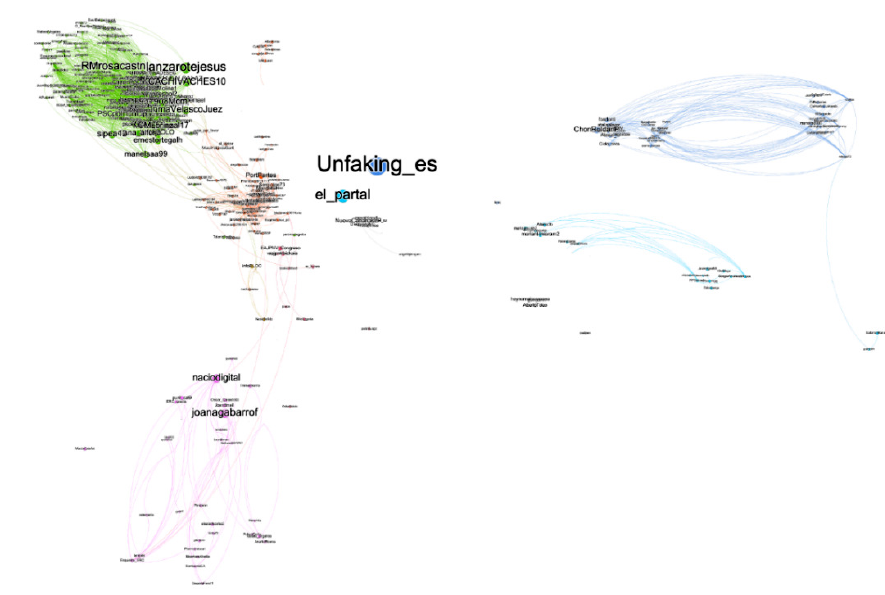
Figure 3. Builders in the retweet